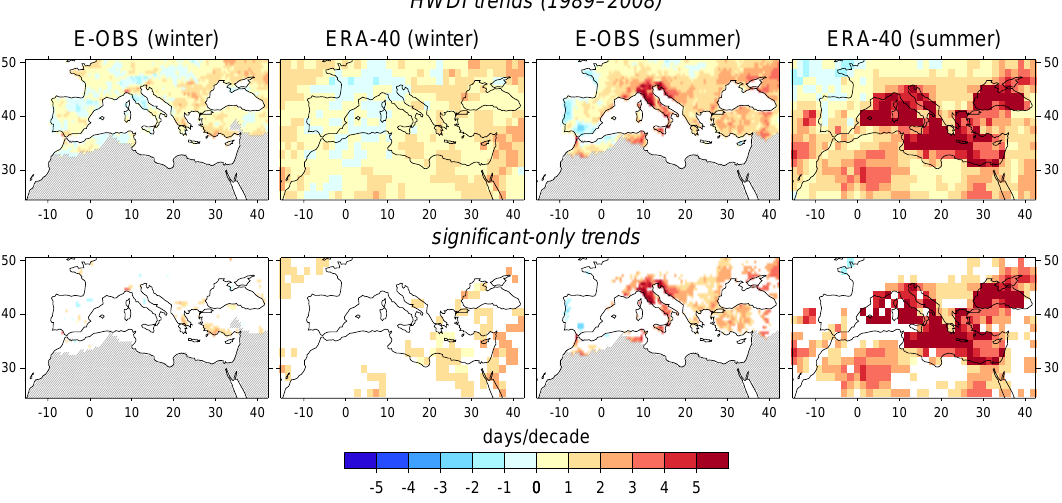
Fig. 5. Trends of winter (left-hand columns) and summer (right-hand columns) HWDI (days per decade), over the period 1989–2008, from E-OBS and ERA-40 data. The lower panel shows only statistically-significant